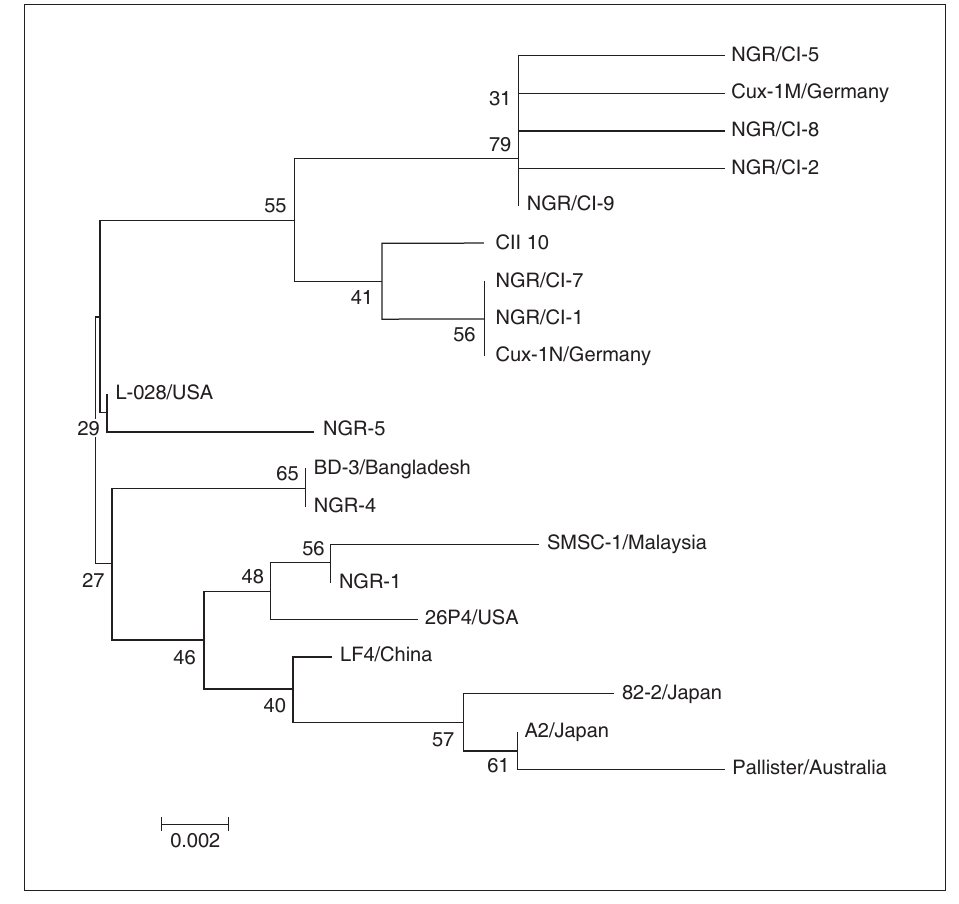
FIG. 1 Phylogenetic relationship among Nigerian and reference CAV strains based on nucleotide se- quence of a fragment of the VP1 gene TABLE 1 CAV sequences used for multiple alignment analysis Strain Geographical origin Genbank accession